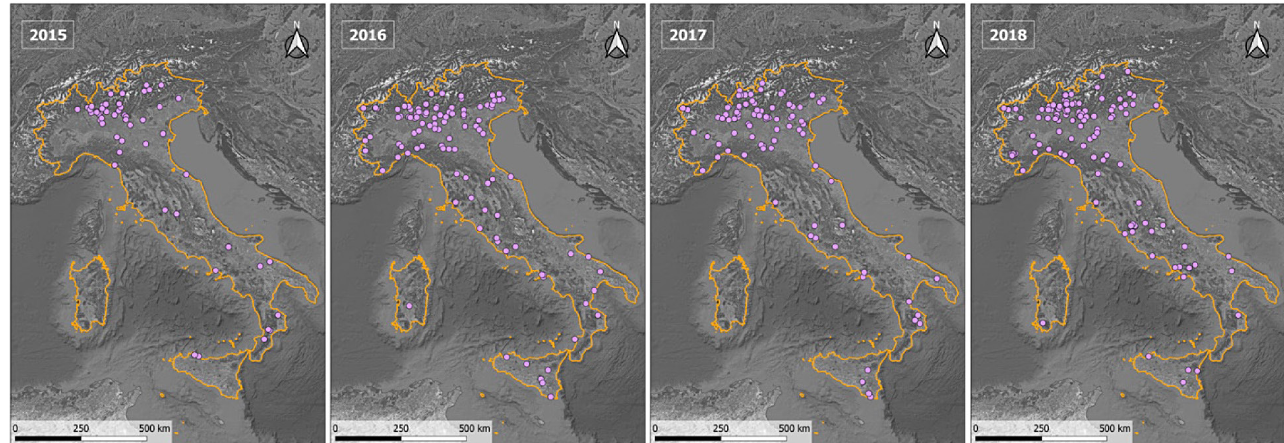
Fig. 1: Geographical origin of the saffron samples (purple dots) divided by year of production/analysis. Orange line shows the borders of